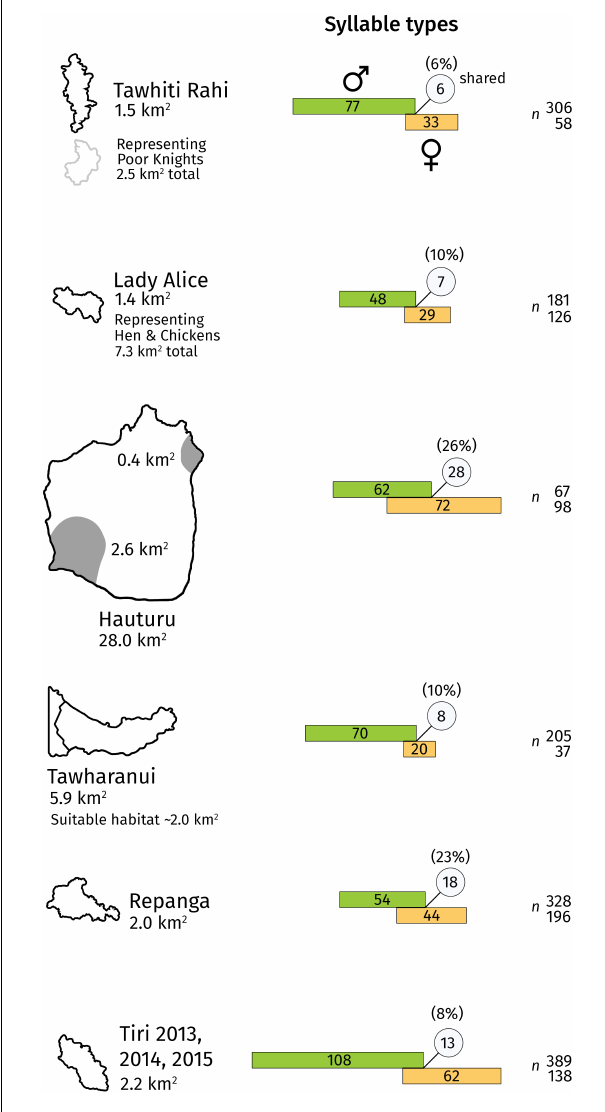
FIGURE 2 | Overlap of male and female population syllable repertoires. Each diagram indicates the recorded number of male (green bar) and female (orange bar) syllable types, and the number of types common to both sexes (circle). The percentage overlap is given above the circle, calculated as the Jaccard similarity index: number of shared types divided by total number of types. For robustness, repertoires exclude types with fewer than three occurrences within that site-and-sex group. Bar length is proportional to the number of syllable types, and overlap length is proportional to the number of shared syllable types. Sample sizes (number of songs) for the male and female bars are given to the right of the bars. Note that repertoire sizes are recorded values, not extrapolated, and therefore are not directly comparable due to differing sample sizes. However, relative overlap percentage is more robust to differing sample sizes and thus meaningful to compare. Site outlines on the left of the figure are to scale. The shaded grey area in the Hauturu outline indicates the sampled region of the